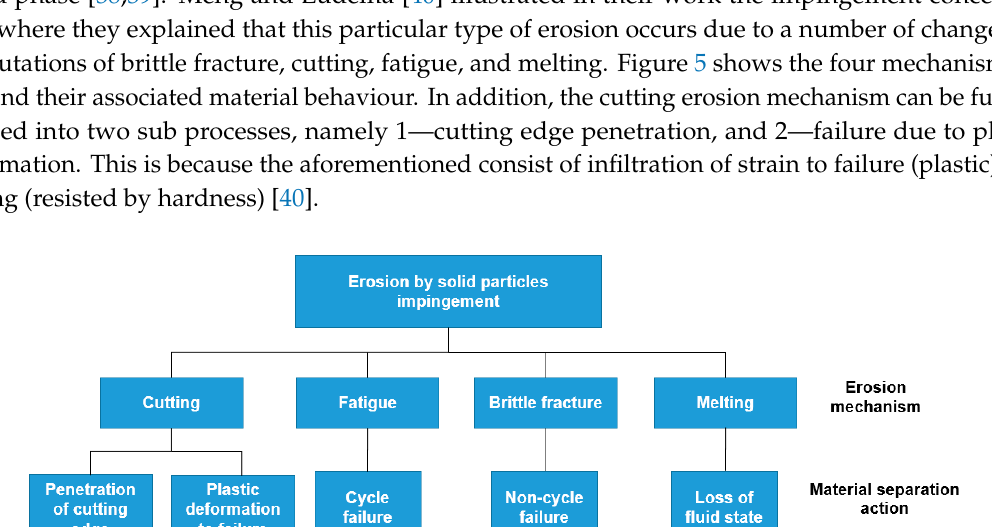
Figure 4. Results from the Scopus database for “Solid particle erosion”, “Coating”, and “Gas turbine” from 1984 to 2019, where ( a ) is publications per year, and ( b ) is the overall percentage for each topic.